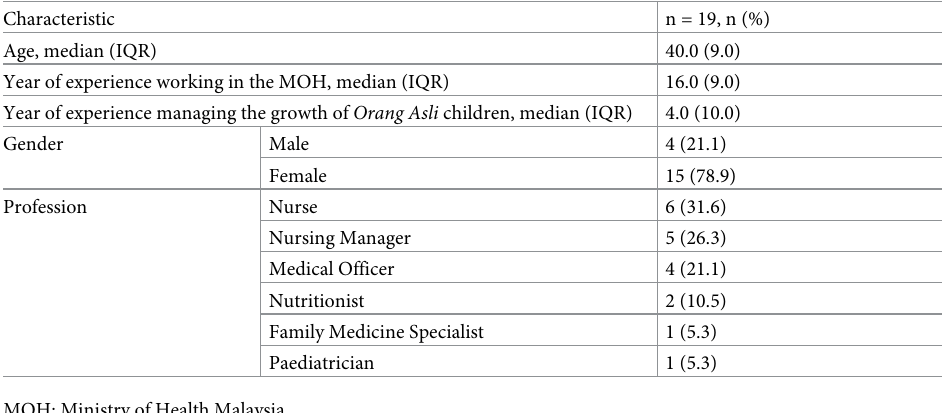
Table 1. Demographic characteristics of the